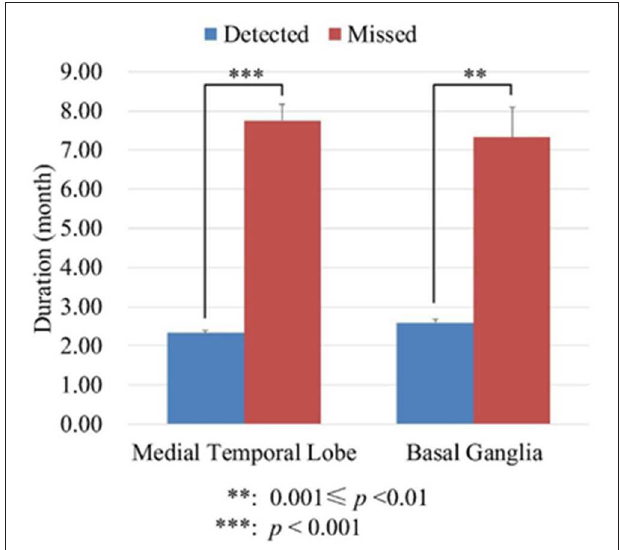
FIGURE 2 | The durations of disease (month) of detected and missed group patients. The detected group meant in these patients abnormal metabolism can be detected by semi-quantitative analysis. The missed group meant in these patients abnormal metabolism cannot be detected by semi-quantitative